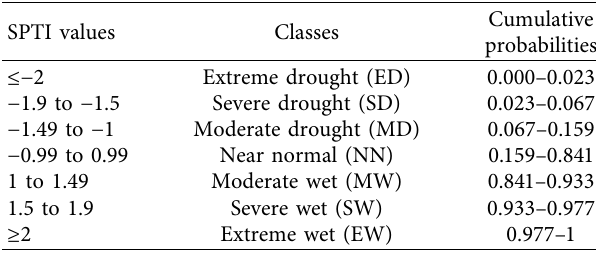
Table 1: Drought classification of the SPTI